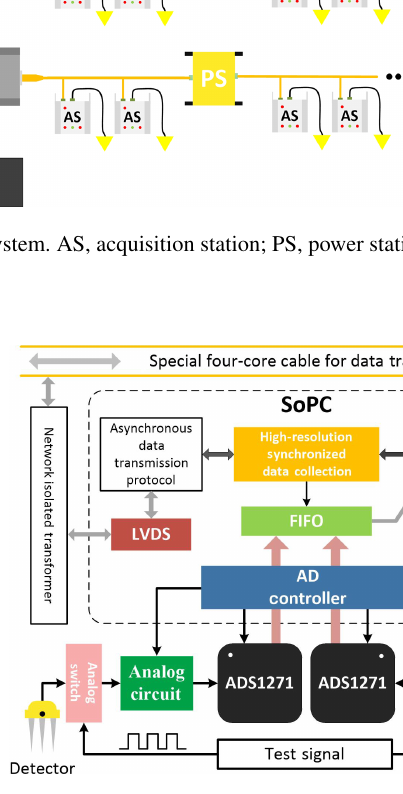
Figure 2. The overall structure of the data acquisition